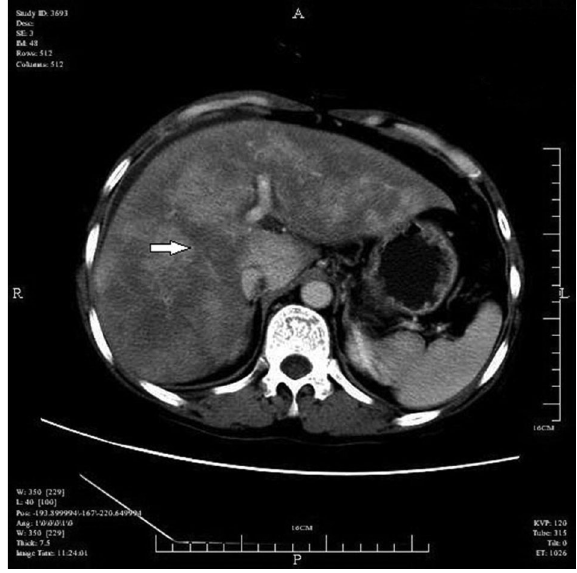
Figure 3. Enhanced liver CT image in the portal venous phase. The arrow shows the density change of the geographic liver